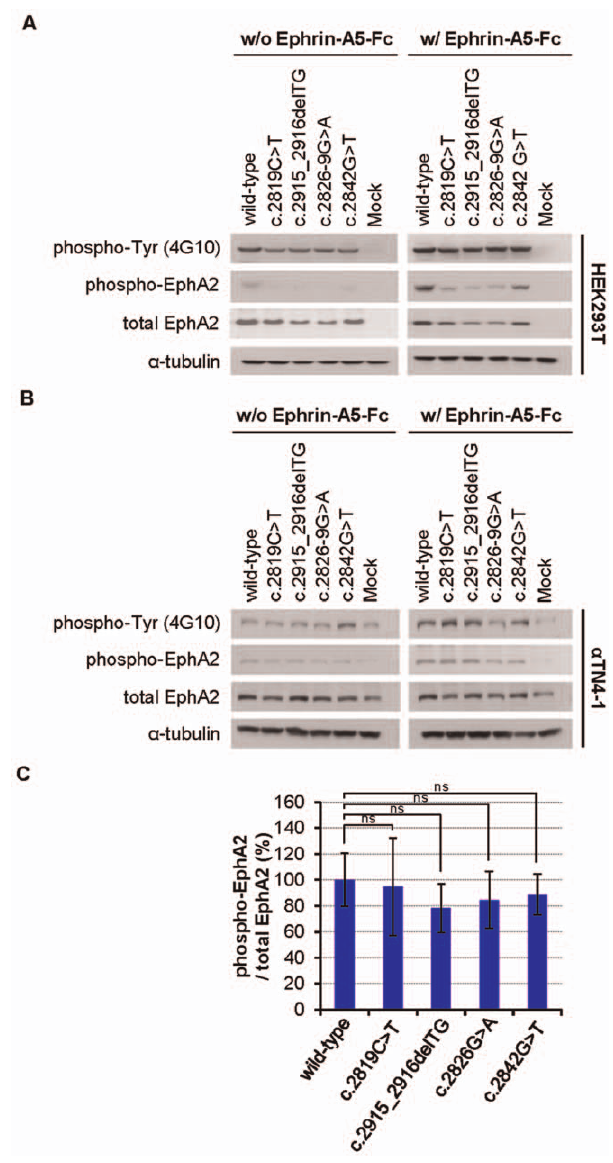
Figure 4. Tyrosine phosphorylation of EPHA2 receptor by ephrin-A5 is not affected by SAM domain mutations. ( A, B ) Ephrin-A5 ligand stimulates EPHA2 phosphorylation. HEK293T ( A ) and a TN4-1 ( B ) cells were grown to confluence and growth